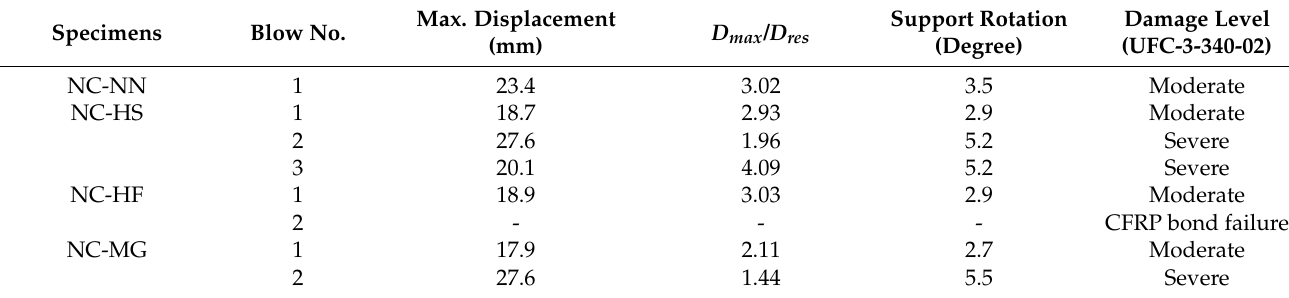
Table 8. Location of the SIP and occupant personnel after the